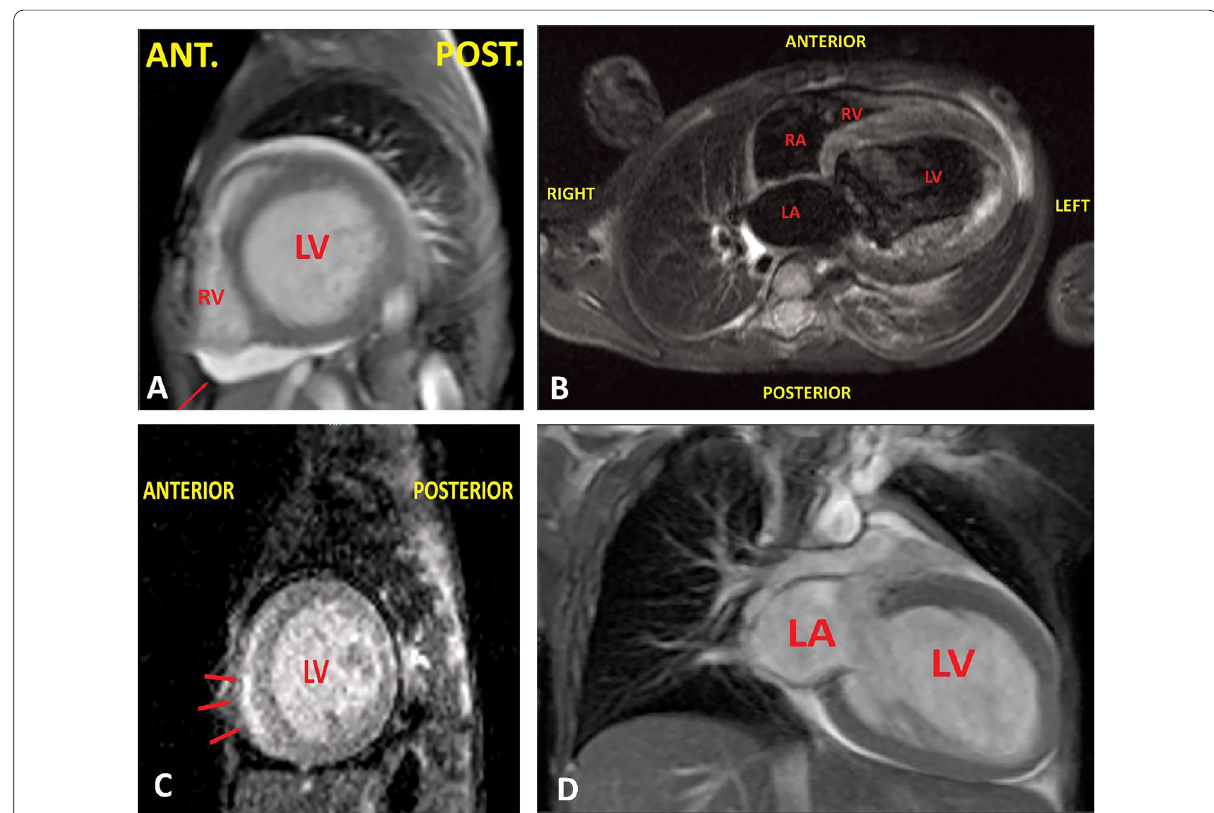
Fig. 8 Cardiac magnetic resonance imaging of the patient. A Pericardial effusion, B indicates diffuse myocardial edema, C depicts late gadolinium enhancement, and D shows a severe enlargement of the left